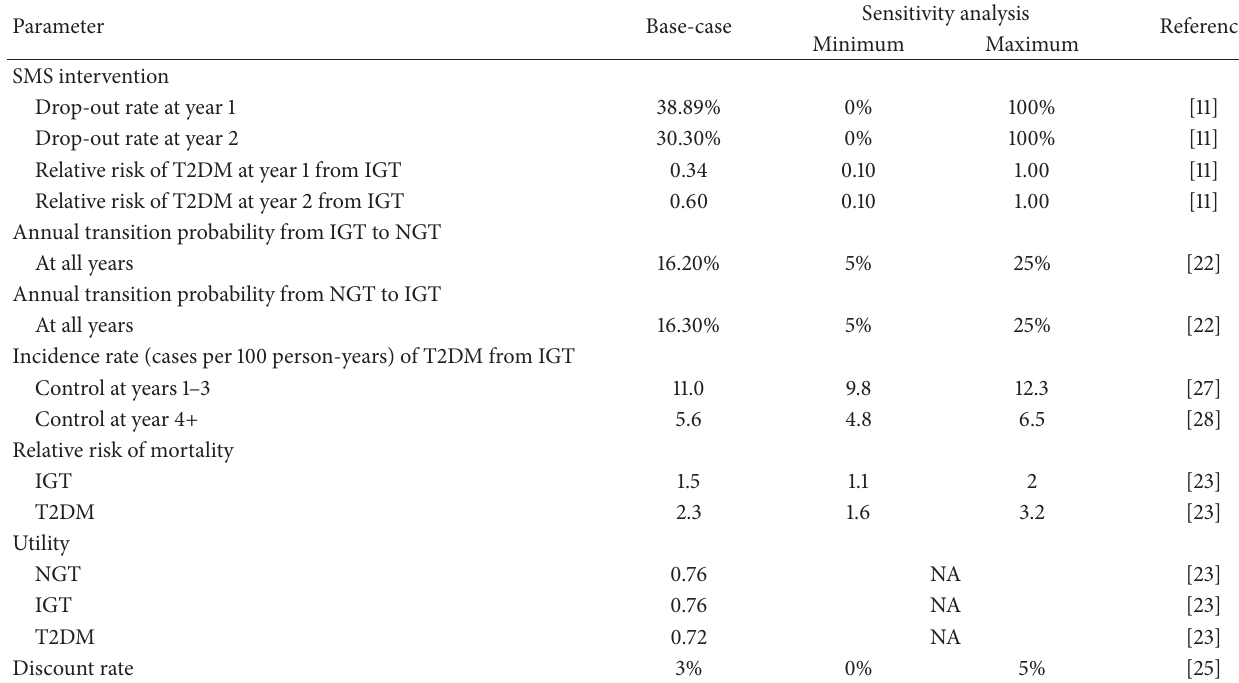
Table 2: Clinical parameter value in base-case scenario and range used in sensitivity analysis.